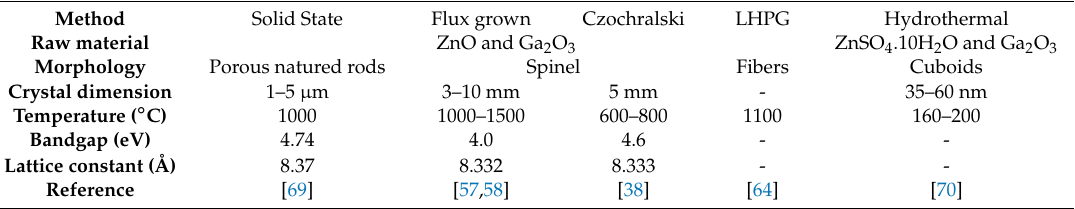
Table 2. Summary of ZnGa 2 O 4 bulk grown methods along with their characteristics.